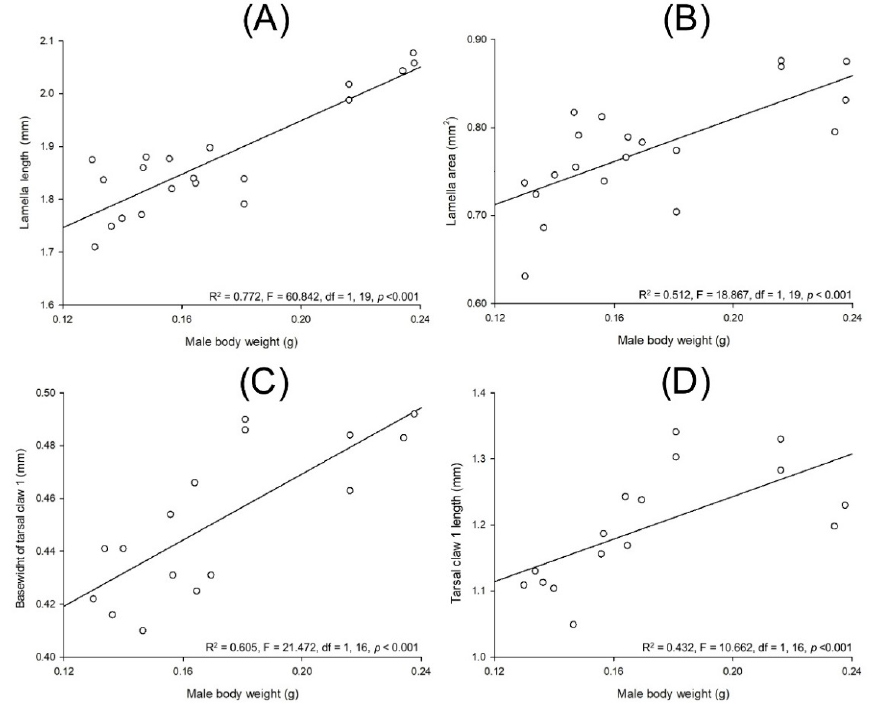
Figure 13. Relationships between body weight and different body parts on Cyclocephala barrerai males: body weight and ( A ) lamella length, ( B ) lamella area, ( C ) width of the base of tarsal claw 1, and ( D ) tarsal claw 1 length.